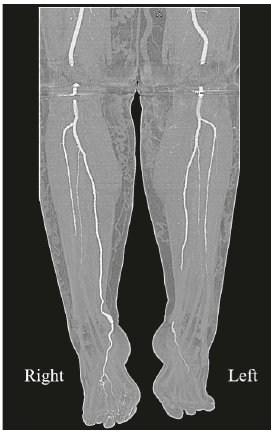
Figure 1: Preoperative reconstructed computed tomography angiography of the tibial arteries bilaterally, demonstrating abrupt occlusion of the left posterior tibial artery and a right-sided posterior tibial artery aneurysm. Please note that artefact from bilateral knee prostheses obstructs visualising normal flow within the popliteal arteries in this image.